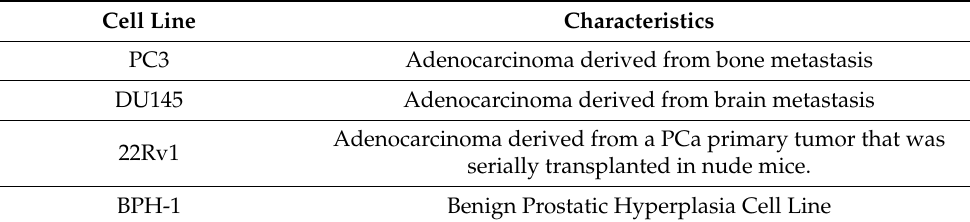
Table 1. List of cell lines and their characteristics.